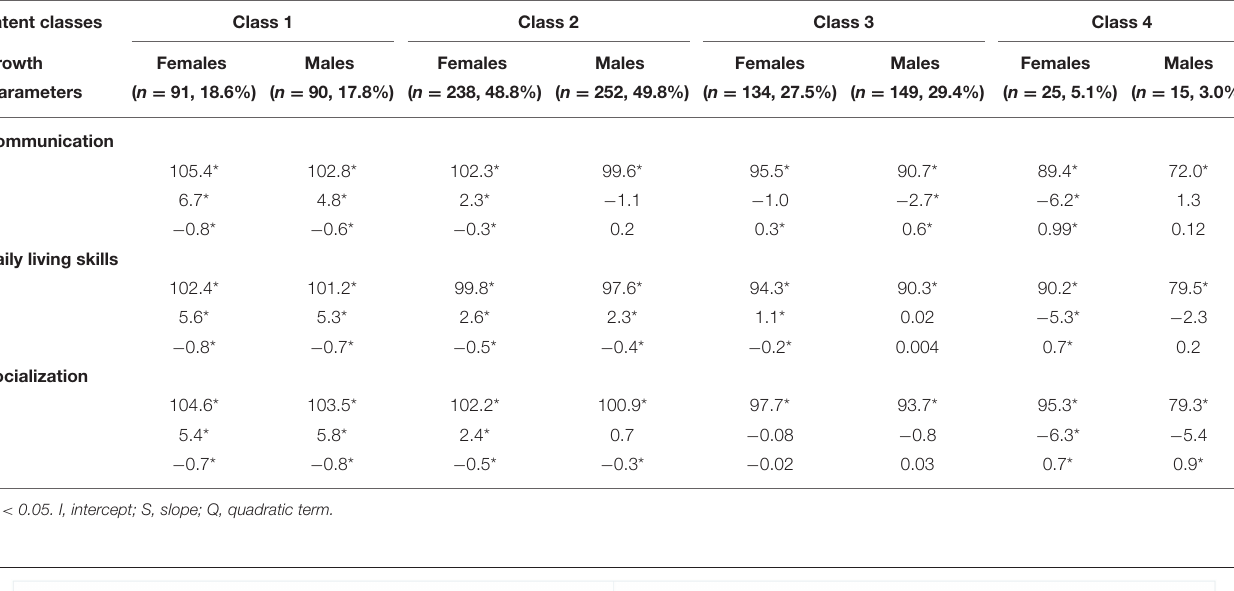
TABLE 2 | Estimated growth parameters in the multigroup latent class growth model.